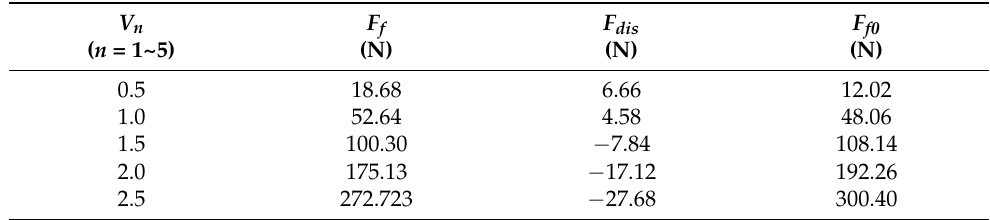
Figure 23. Variation of resistance coefficient of DPV underwater cruising. According to various resistance coefficients, the actual resistance F f , resistance of restraint movement F f0 , disturbance term F dis and speed V are shown in Table 9. Table 9. Resistance and speed.